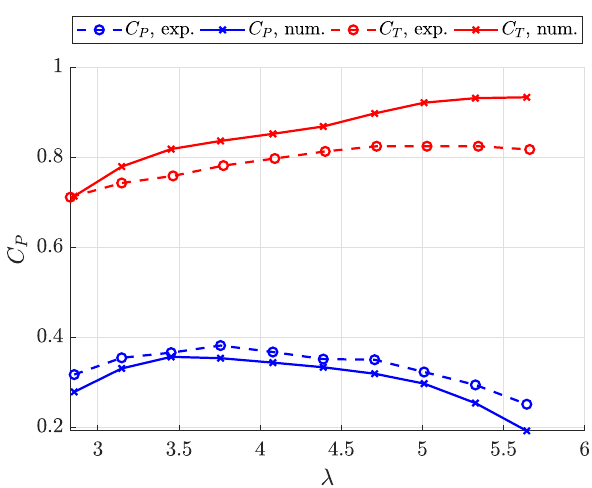
Figure 3. Power coefficient C P and thrust coefficient C T of the turbine. Experimental values from [29,30].